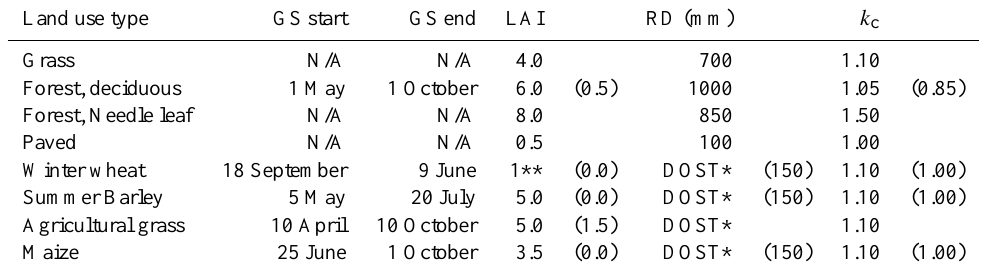
Table 2. Growing season (GS) for each land use type in the model as well as leaf area index (LAI), root depth (RD), and crop coefficient ( k c ) . Values in parenthesis indicate the value of the parameter outside the GS (if different from the parameter value in the GS).